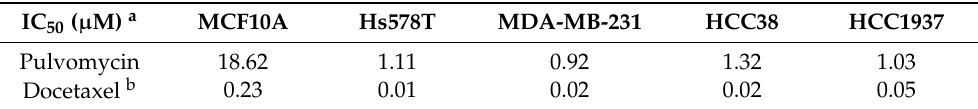
Table 1. Antiproliferative activities of pulvomycin against human triple-negative breast cancer (TNBC) cell lines.